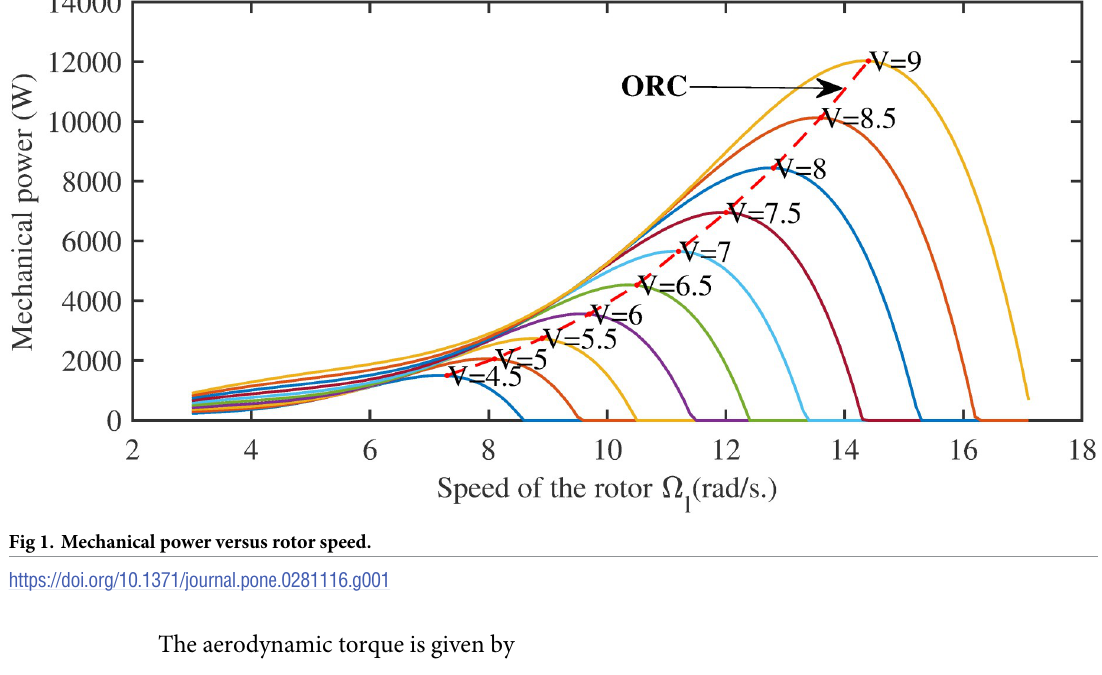
Fig 1. Mechanical power versus rotor